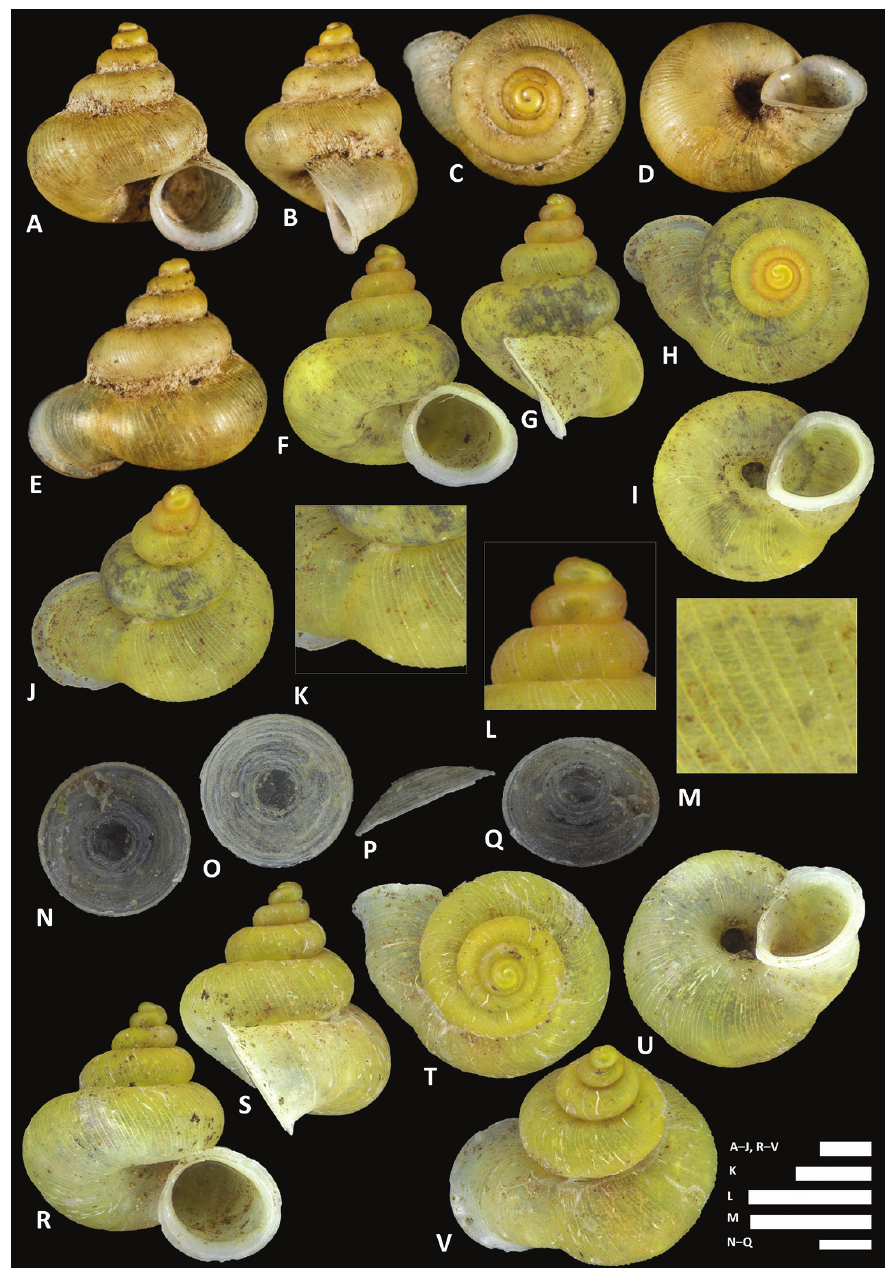
Figure 20. Alycaeus kapayanensis Morgan, 1885b. A–E Shell of syntype, MNHN-IM-2000-31792 F–J Shell of BOR/MOL 10793 K–M Close up of shell of BOR/MOL 10793 N–Q Operculum of BOR/MOL 6845 R–V Shell of BOR/MOL 11385. Scale bars: A–L 1 mm; M–Q 0.5 mm. Photographs A–E by Manuel Caballer (reproduced herein under CC-BY 4.0 license, Project RECOLNAT, MNHN). Photographs F–V by Junn Kitt